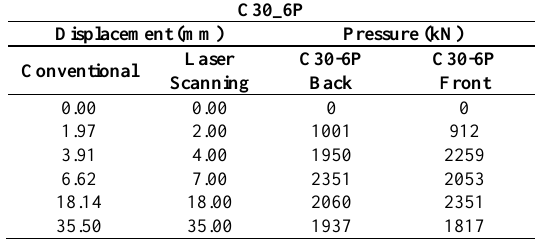
Figure 11. Change of volume for both